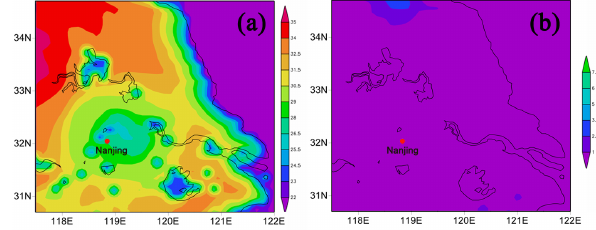
Fig. 8. Simulated (a) 2m air temperature at 14:00LT, 10 June and (b) 6h total rainfall for the period of 12:00–17:00LT on 10 June using WRF-FDDA observation nudging with 2m air temperature at Nanjing.